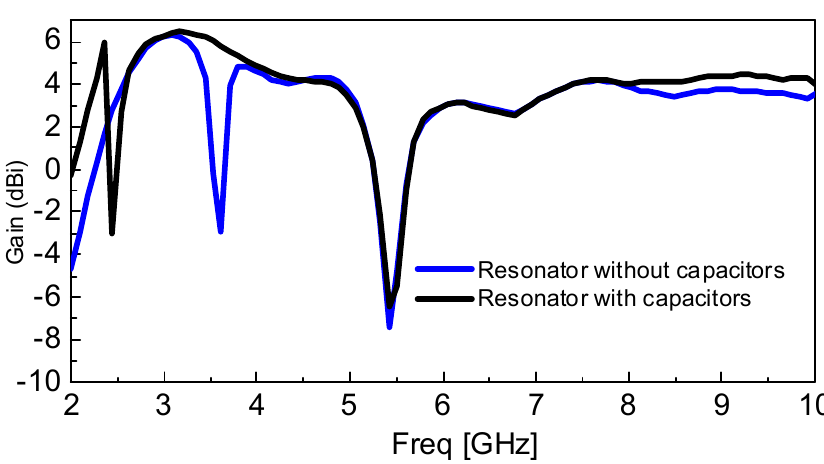
Figure 11. Antenna Gain (dBi) in case of resonator with and without capacitors.